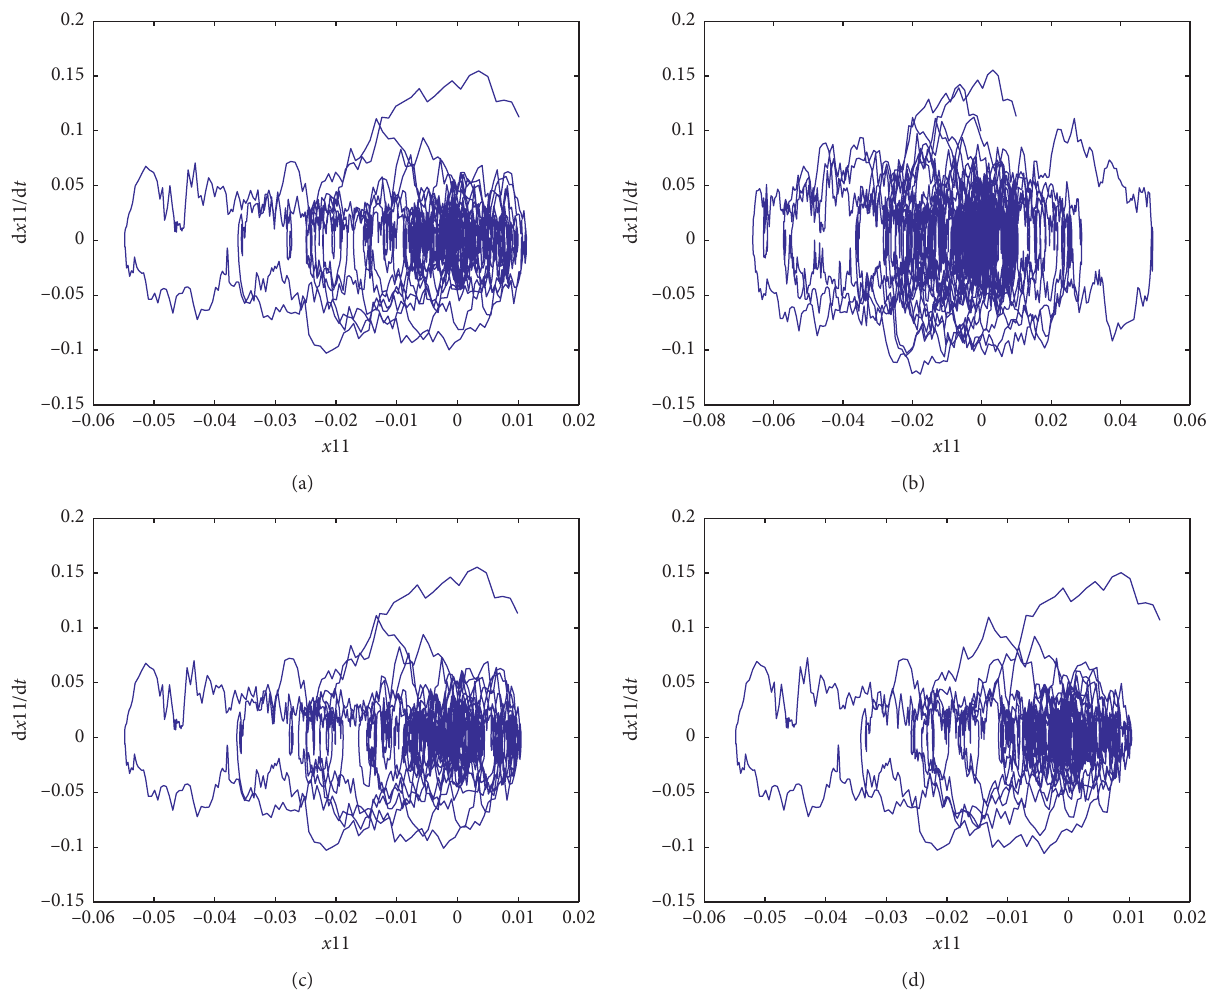
Figure 6: Phase portrait of horizontal displacement of 11 th story considering functions sign ( s ) and tanh ( s / ε ) . (a) sign ( s ) (c). ε � 0 . 01. (d) ε � 0 . 001.